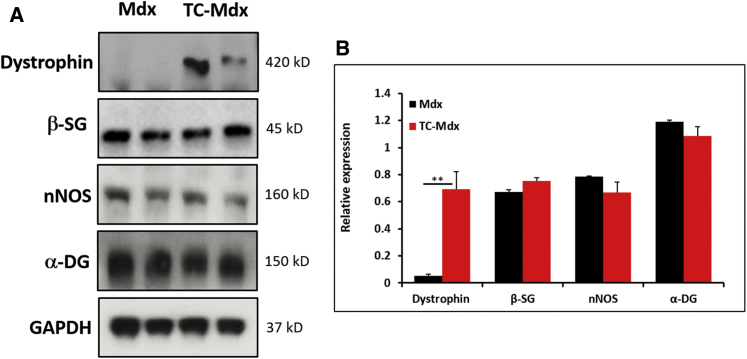
Western Blot Analysis of DAPC Proteins in 20- to 22-Week-Old Male Mice(A) Western blot image of DAPC proteins in the TA muscle. (B) Quantification of DAPC proteins relative to GAPDH. Note the robust expression of β-sarcoglycan, nNOS, and α-dystroglycan in untreated mdx muscle (n = 3 for each cohort). **p < 0.01. Statistical analysis was performed using two-tailed t test.